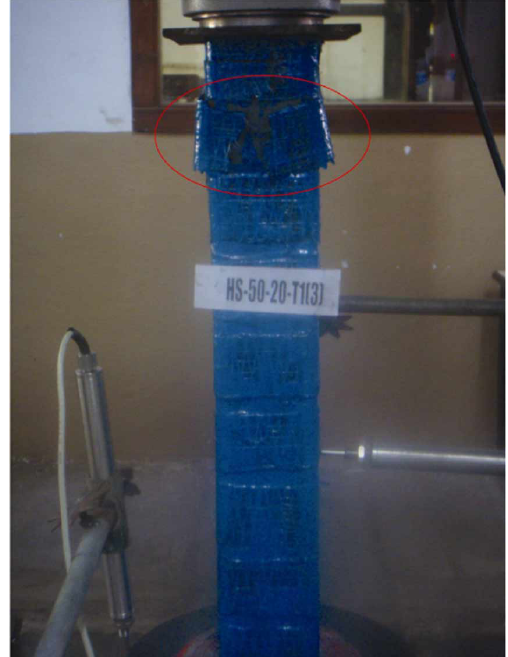
Fig. 4. Failure mode of column HS-50-20-T1(3) Fig. 6. Failure mode of column